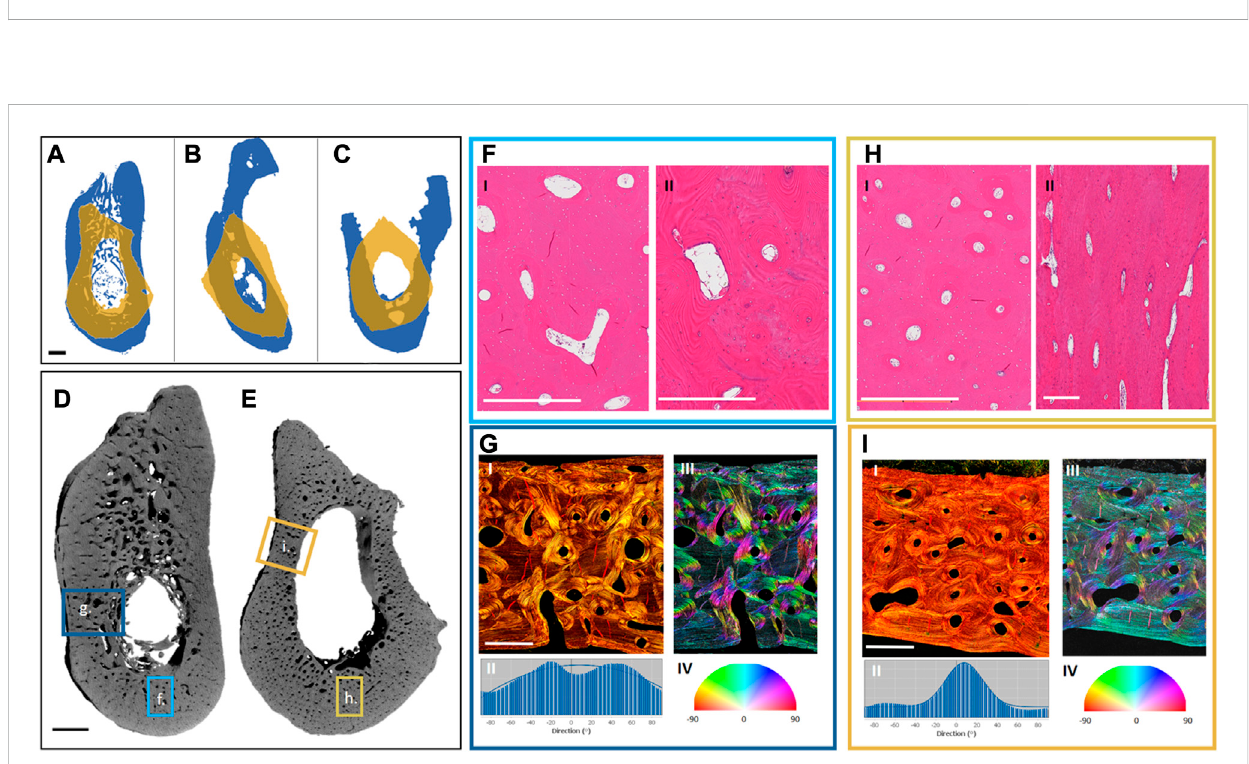
FIGURE 3 Preliminary analysis of differences between the mandible and the fi bula. Projections of the exemplary cross-sections of three different patients (A – C) :Themandibularprojectionsinblueandtheoverlayingprojectionsofthecorresponding fi bulasinyellow,showingthedifferencesintheshapeand size of the bones. Three different fi bula shapes can be noted: Irregular (A) , triangular (B) , and quadrilateral (C) . Renderings of one of the patient samples reveal the different complexity in the morphology of the mandible (D) and the fi bula (E) . Highlighted hematoxylin and eosin (H, E) -stained regions from the mandible (F) and fi bula (H) — Cross-sections of the mandible (F, I) and fi bula (H, I) — Reveal a more homogeneous size and distribution of the Haversiancanalsinthe fi bula,andalargervascularareainthemandible.Further,regionallongitudinalsectionsinthemandible (F,II) and fi bula (H,II) again showamoreregularlongitudinallyalignedHaversiansysteminthe fi bula.HighlightedPicrosiriusred-stainedregionsfromthemandible (G,I) and fi bula (I, I) were analyzed for the directionality of their fi ber bundles (G, II, I, II) , showing higher multi-directionality in the mandible (G, II, G, III, G, IV) than in the fi bula (I, II, I, III, I, IV) . The black scale bar is 2 mm and the white scale bar is 500